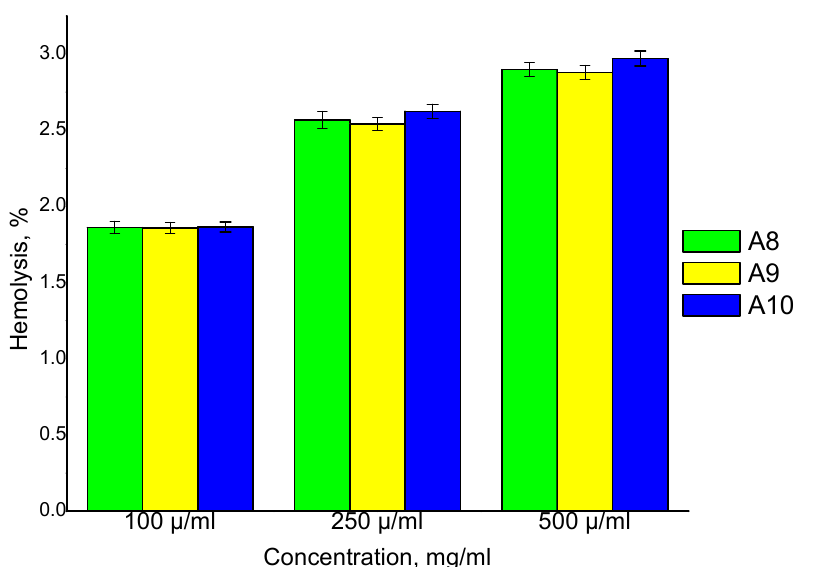
Figure 11. The influence of CPH concentration on the degree of hemolysis (samples A8, A9, A10). The viability of HDMVEC cells (Primary Dermal Microvascular Endothelial Cells) in 2D culture treated with nanoparticulated formulations (A9) was not affected by the presence of glutaraldehyde in the CPH structure (Figure S5).